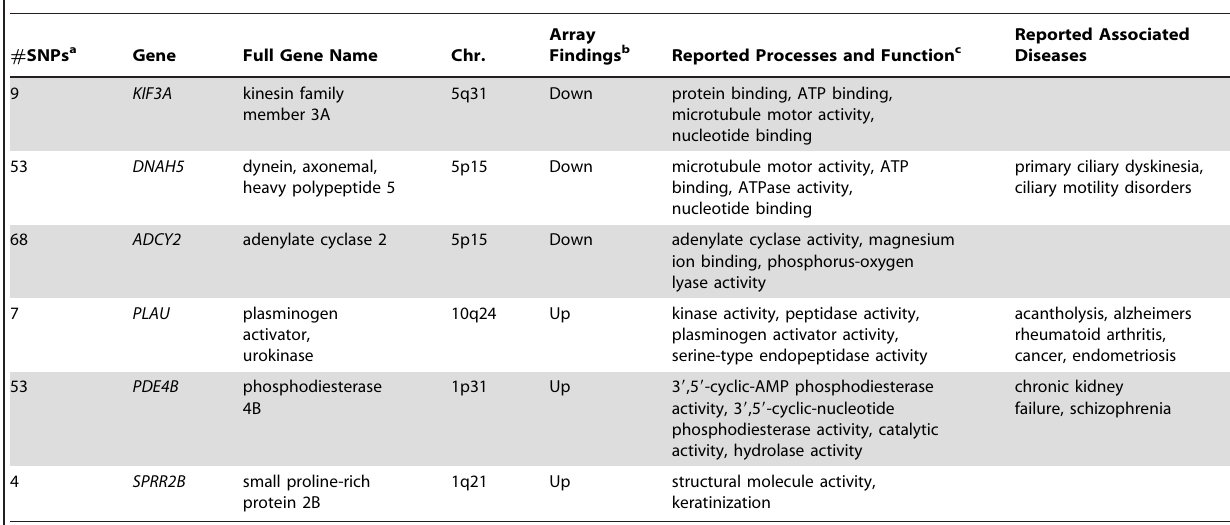
Table 1. Selected genes and